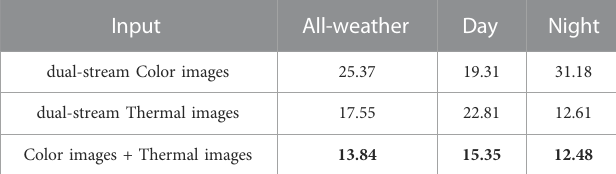
TABLE 1 Experimental results of baseline under different fusion modes.